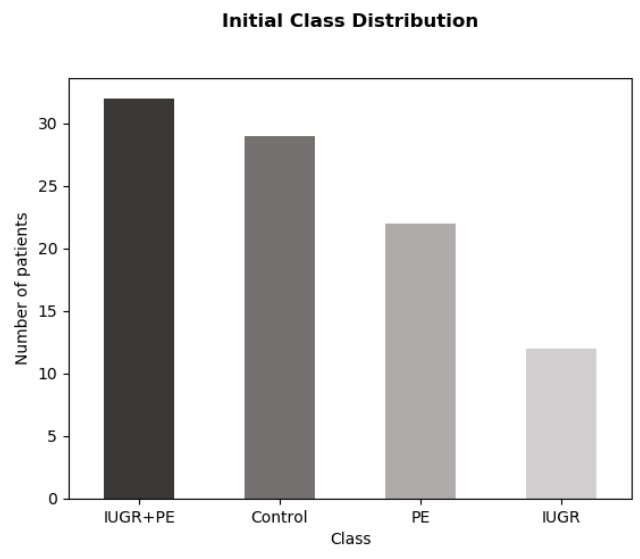
Figure 1. Initial distribution of the